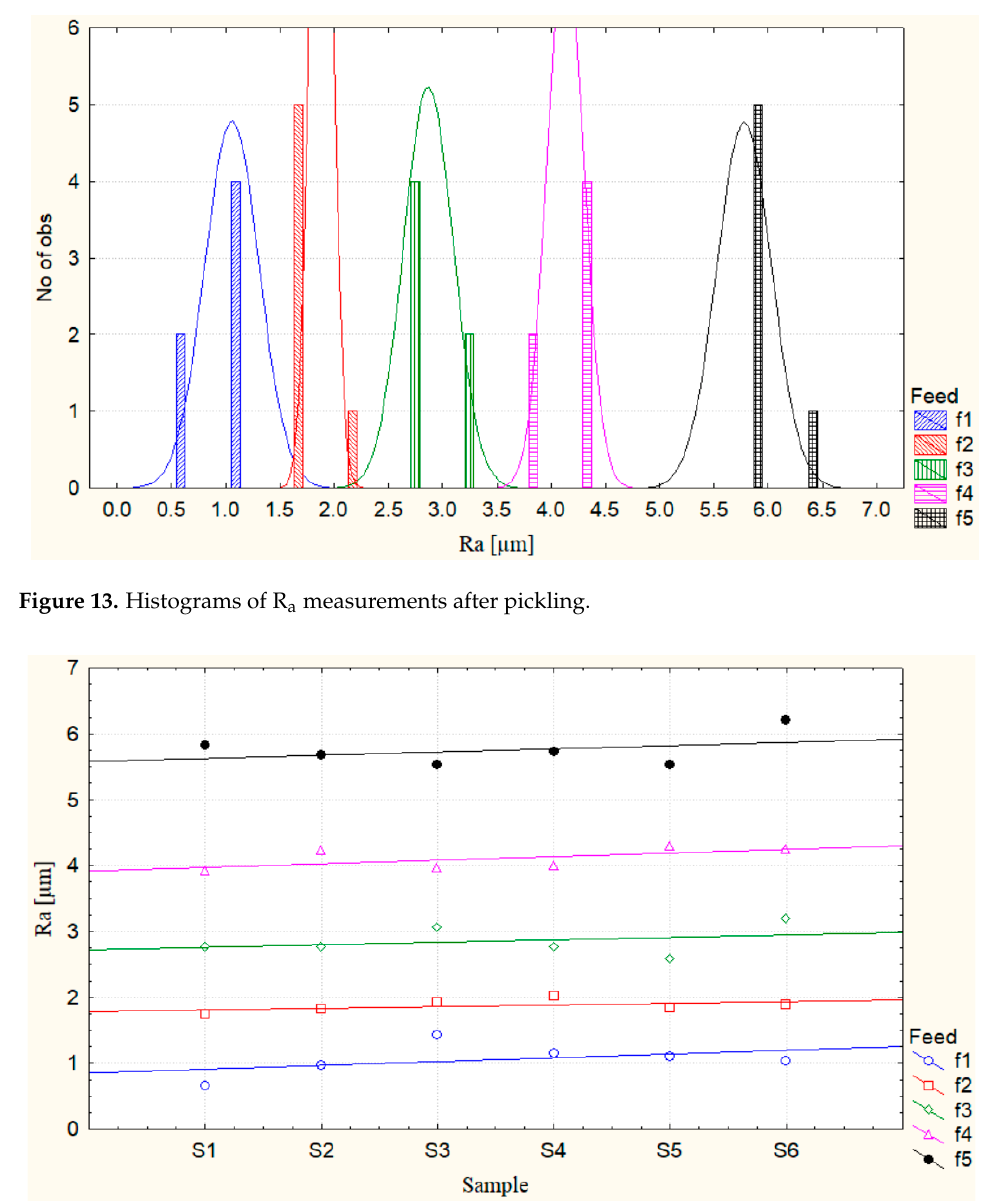
Figure 14. Scatter plot of the R a measurements after pickling on the sample sections. Table 9. Means with 95.0 percent LSD intervals.